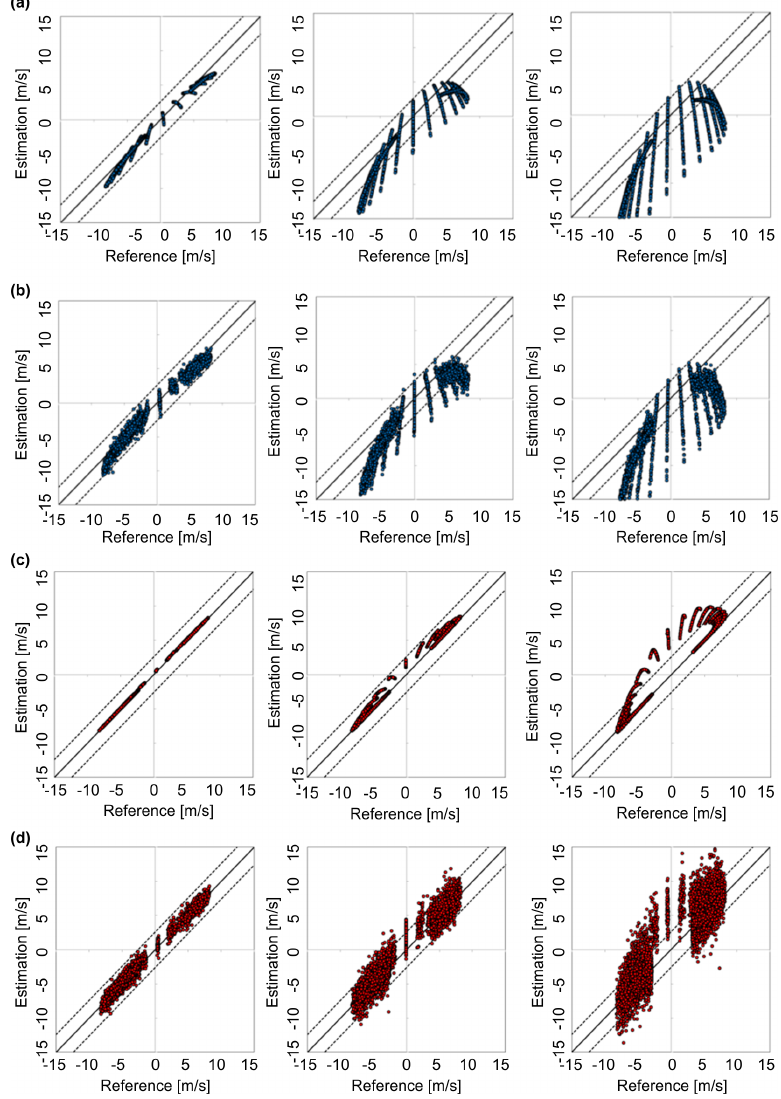
Figure 19. Cross-plots of the reference and the estimated vertical wind data. Left figures: 100m LOS distance; middle figures: 300m LOS distance; right figures: 500m LOS distance. (a, b) Simple vector conversion; (c, d) proposed method. (a, c) Cases without error and noise; (b, d) cases with error and noise. The dots indicate the wind speed estimated at 5Hz, and the dotted lines indicate the performance demand for